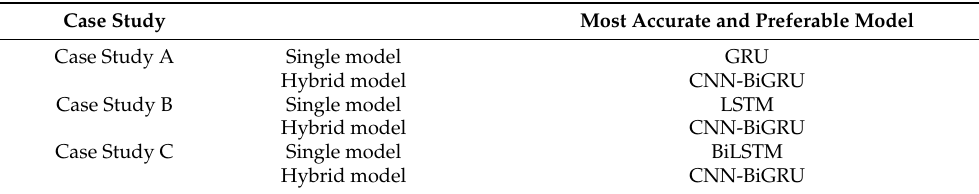
Table 7. A summary of the performances of the proposed deep earning models for the three case studies.